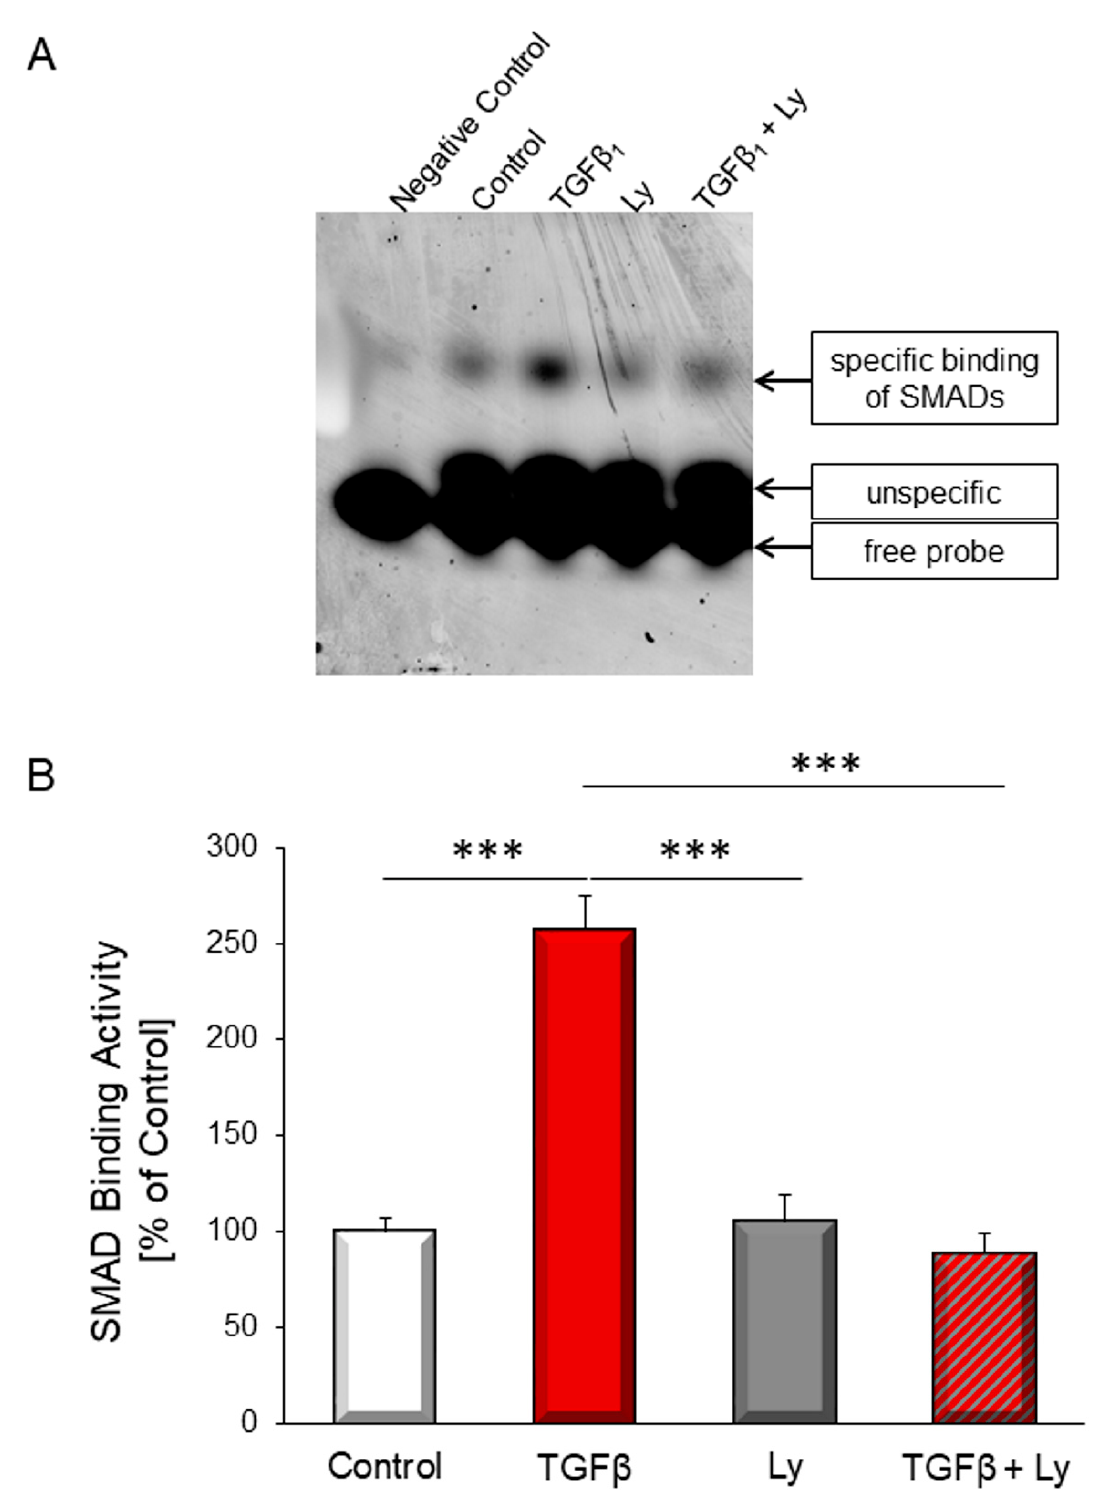
Figure 2. TGF β 1 –induced SMAD binding activity was determined with and without addition of PI3K inhibitor Ly294002 (10 µM) after two hours stimulation with 1 ng/mL TGF β 1 . ( A ) Shows a representative EMSA and ( B ) the quantitative analysis. Data are shown as means ± SEM of four different rat cardiomyocytes preparations. Significance is indicated by *** p < 0.001.